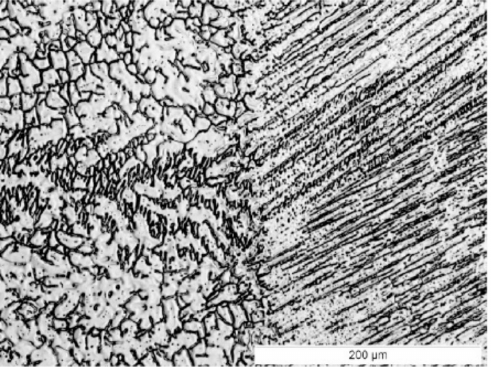
Figure 23. Microstructural shifts in SS304. Reprinted from Ref. [67].